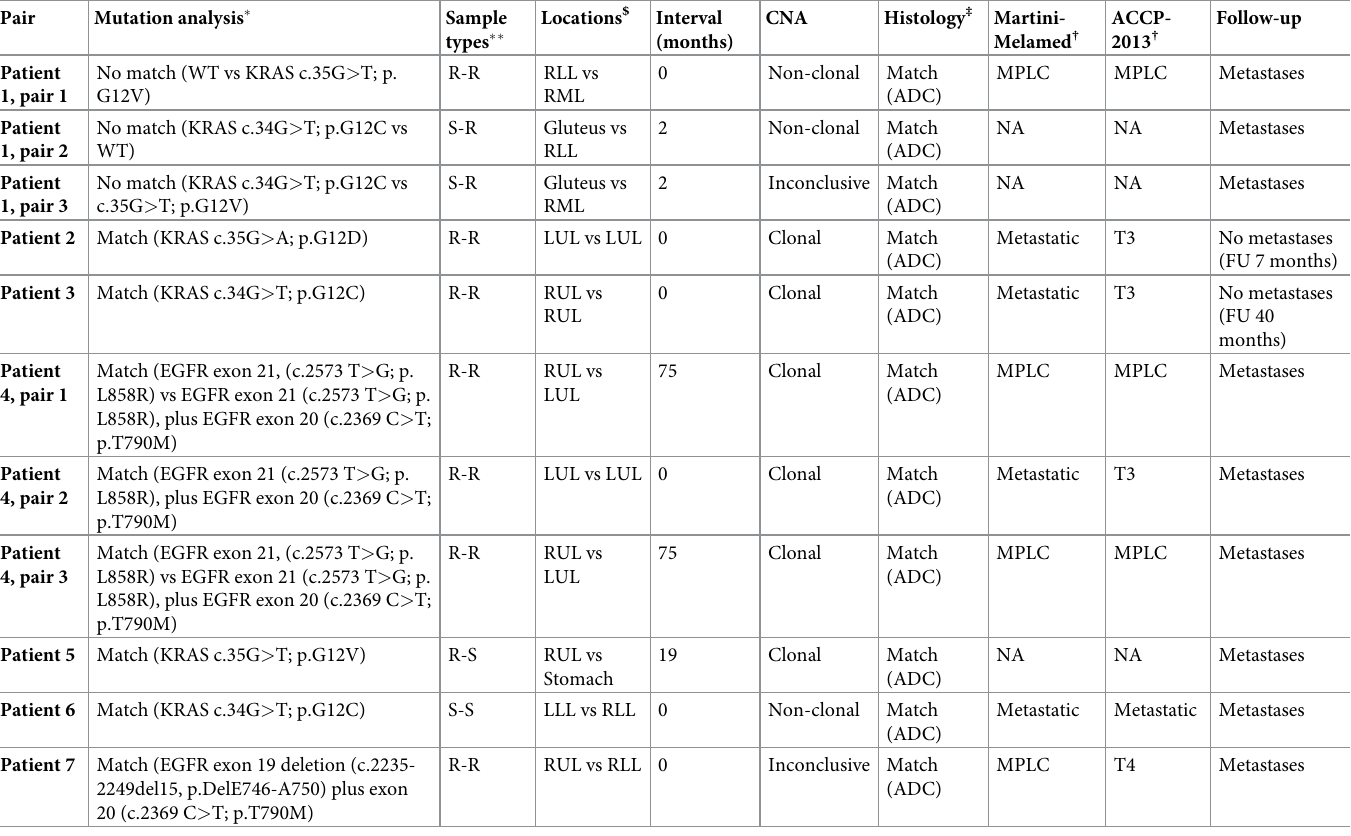
Table 5. Details of pairs (n = 11) with mutation analysis performed upon both tumor samples. Pair Mutation analysis